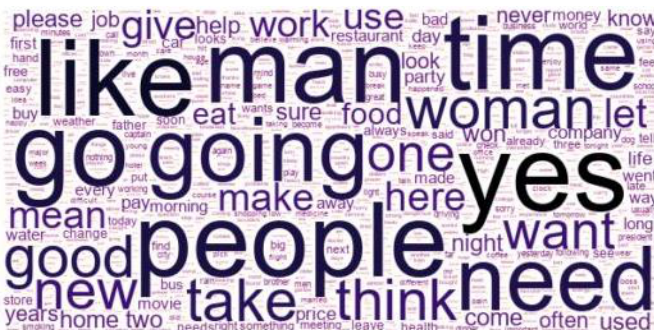
Figure 2. Word cloud of the CEFR A2 level word list.